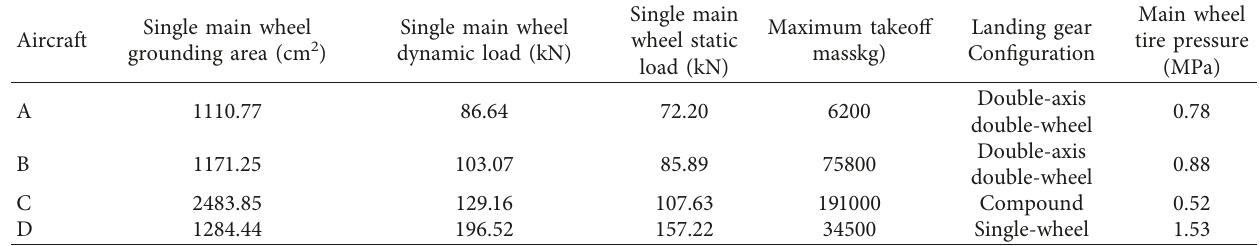
Table 3: Four main Aircrafts’ partial parameters.